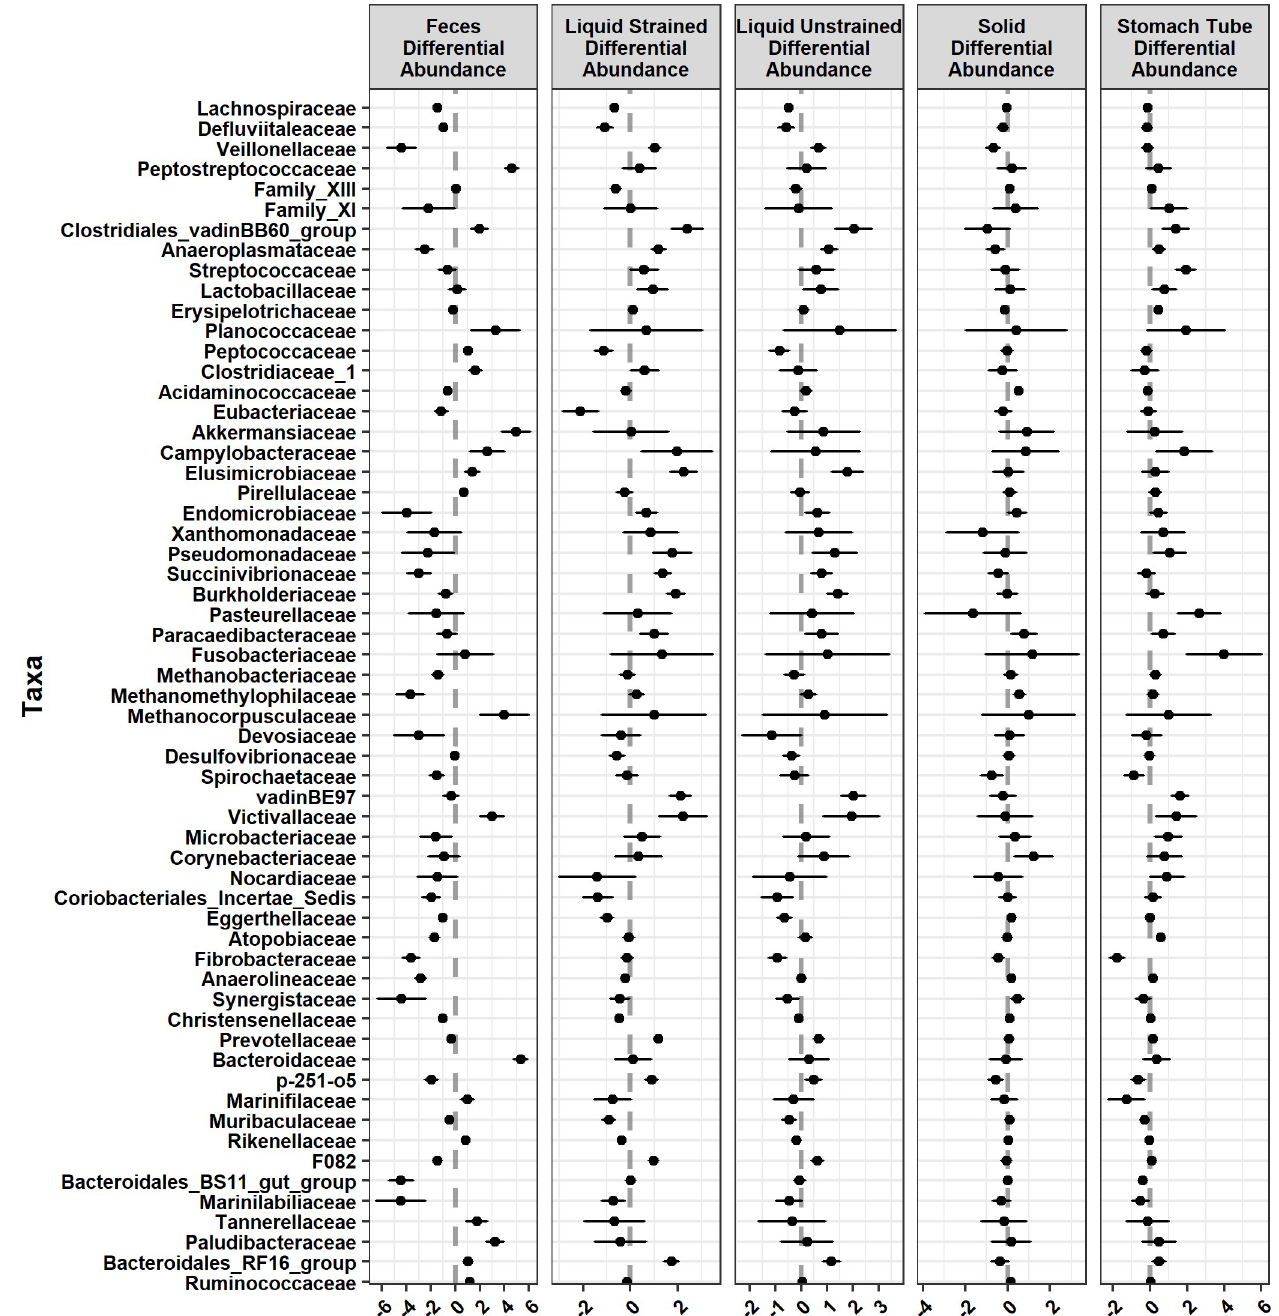
Fig 6. Families that were significantly differentially abundant across sample type compared with grab samples. Graphed as coefficients with a 95% confidence interval calculated from the corncob model. Families with negative coefficients for a sample type are expected to have a lower relative abundance when compared to the grab samples while positive coefficients suggest a higher relative abundance in that sample type compared to grab